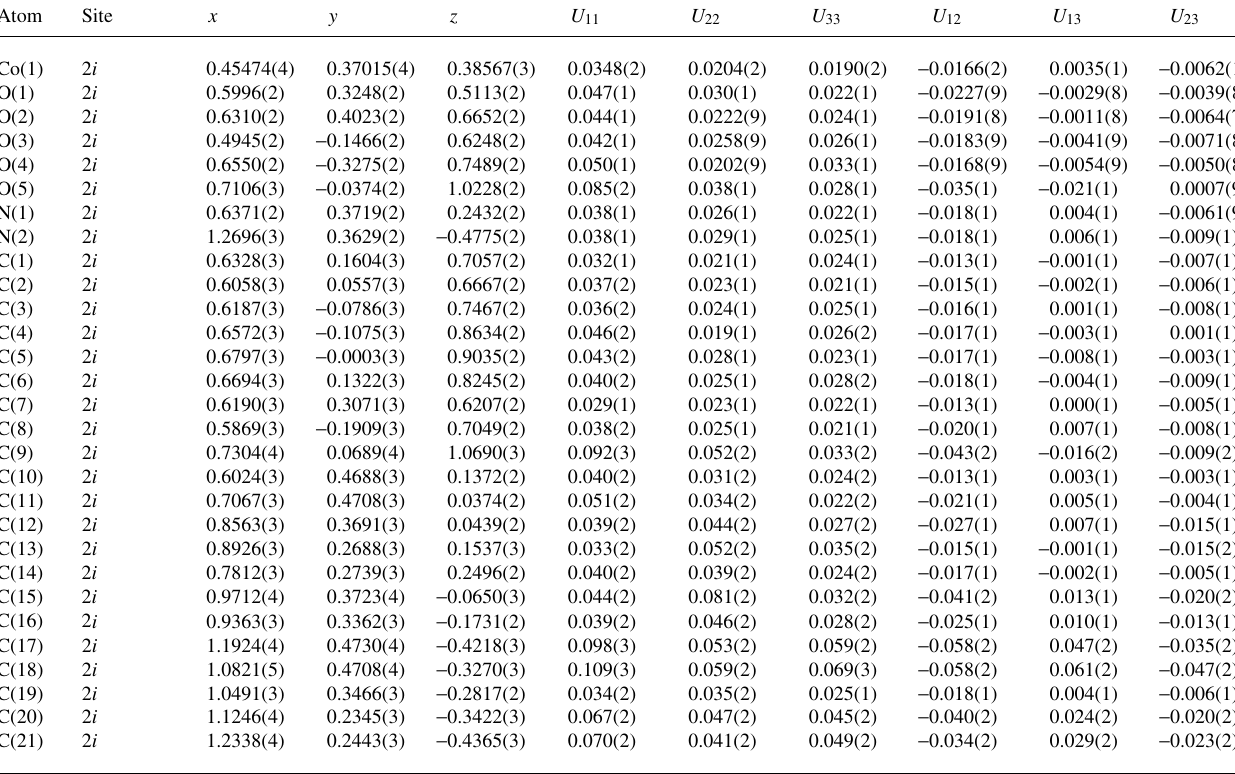
Table 3. Atomic coordinates and displacement parameters (in Å 2 ) .